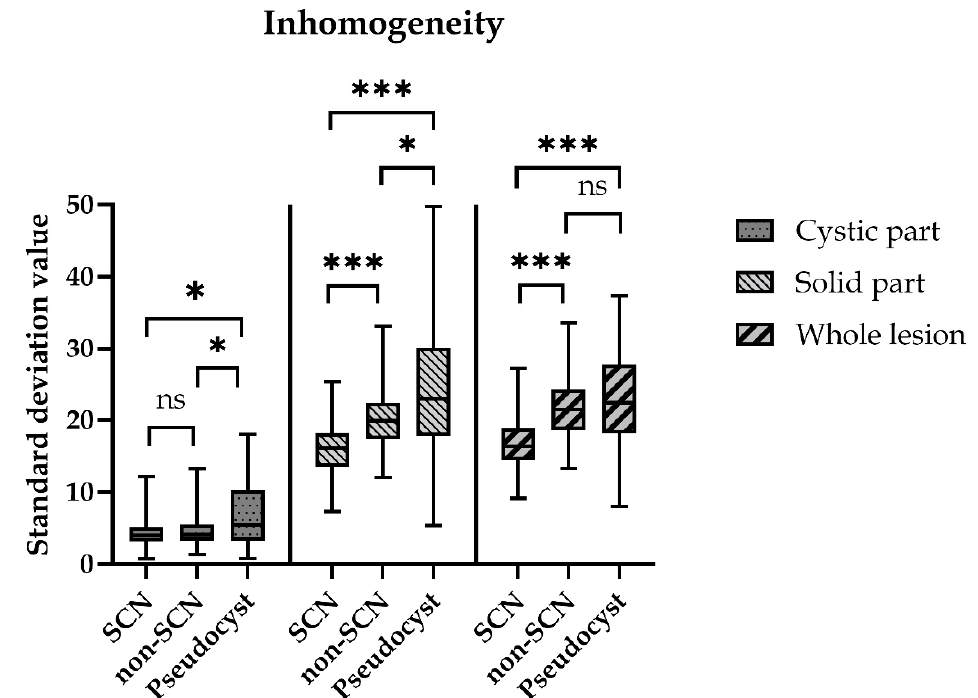
Figure 5. Inhomogeneity values of the different parts of cystic lesions. The inhomogeneity of the lesions was measured by the difference in the gray value of the pixels of the selected areas, which was the standard deviation of the gray value of the selected area. (ns = non-significant; * p < 0.05 *** p < 0.0005).